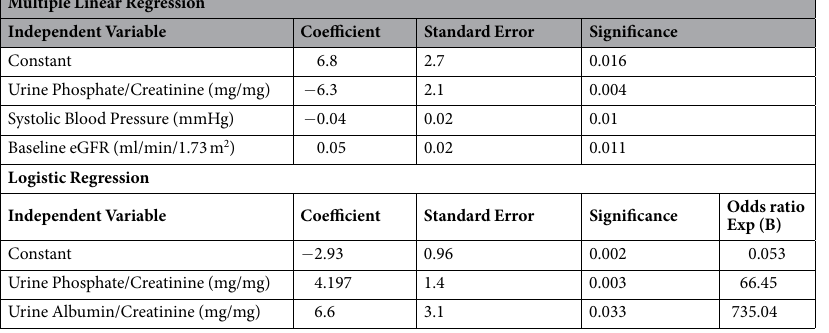
Table 5. A. Forward stepwise Multiple Linear Regression, dependent variable: Change in estimated Glomerular Filtration Rate (eGFR) and B. Logistic Regression, dependent variable: Progressor status.